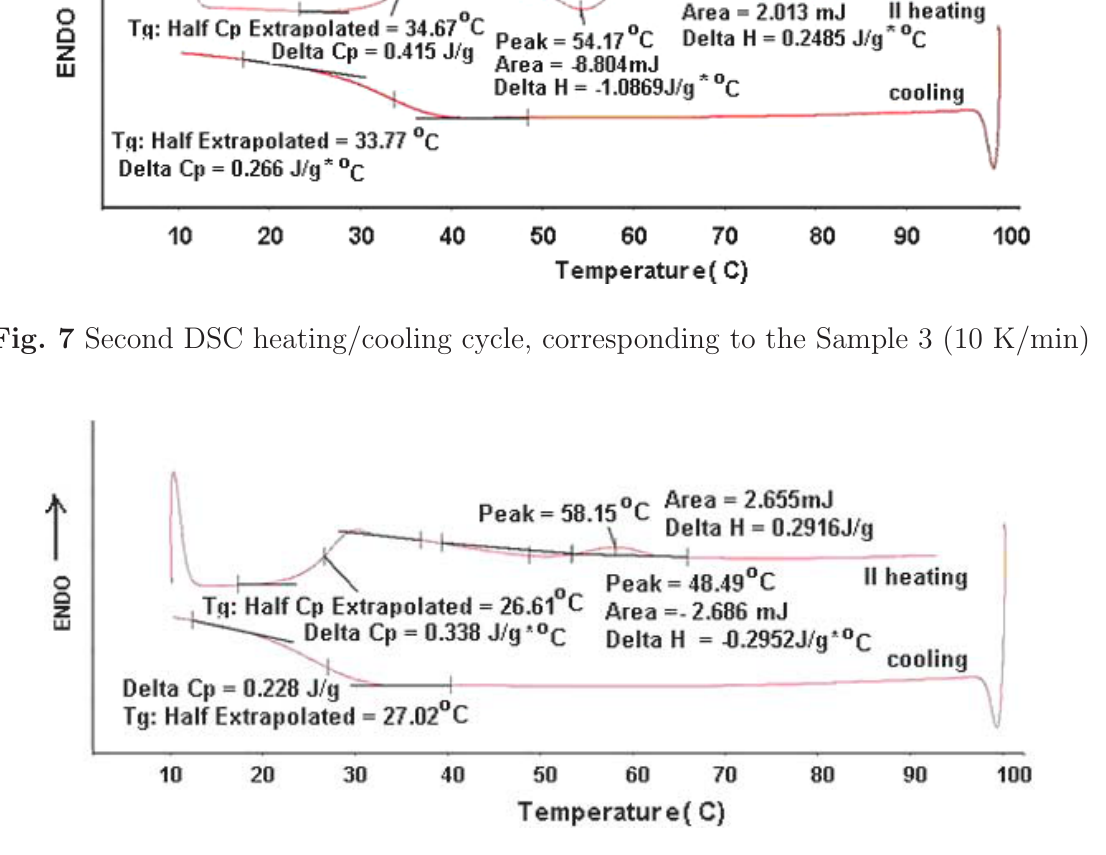
Fig. 8 Second DSC heating/cooling cycle, corresponding to the Sample 2 (10